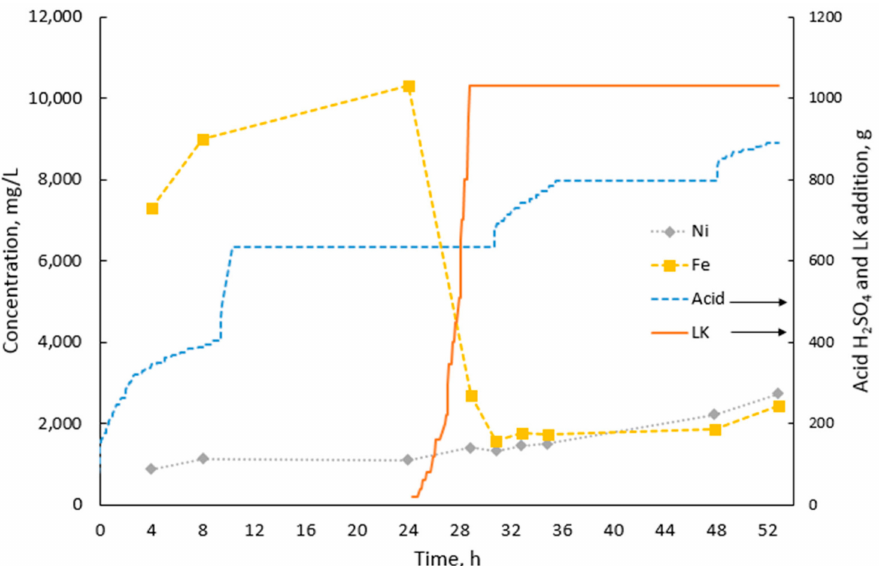
Figure 5. Leaching of LAI for 24 h at pH 0.75, followed by LK laterite addition increasing the pH to 1.8. Concentrations of Ni, Co, Fe, acid, and LK additions. Parameters used in the experiments: 90 ◦ C, S / L = 30%, 800 rpm.